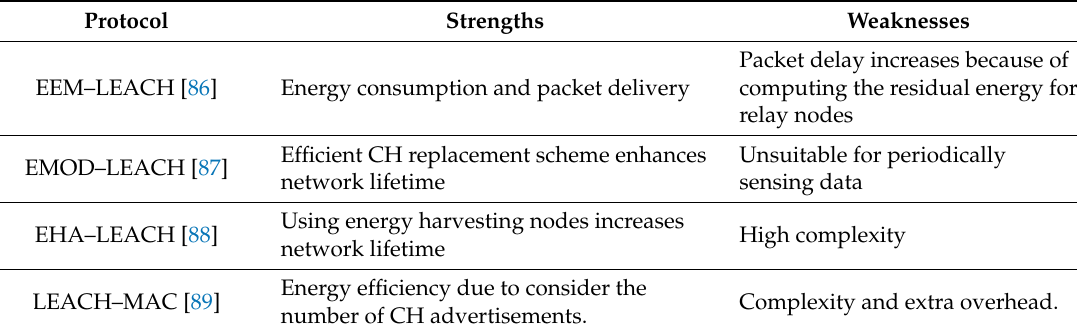
Table 5. Summary of energy efficiency-based CH selection